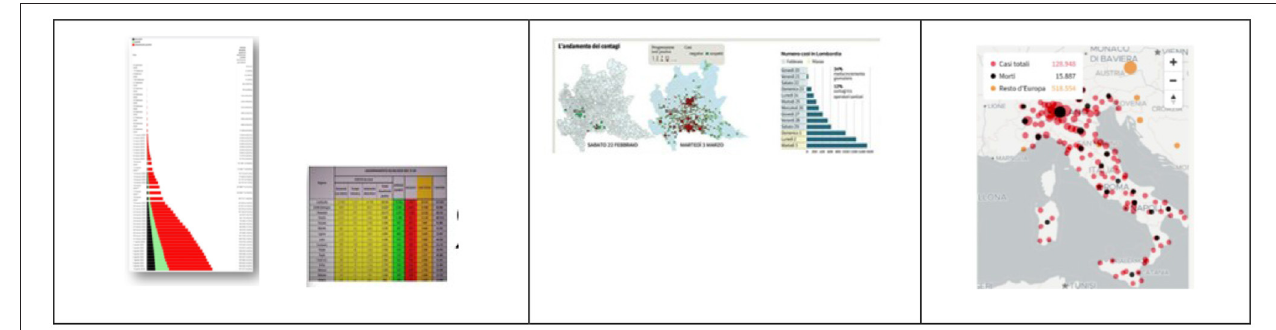
FIGURE 7 | Statistical analysis data organized by students’ workgroups on the daily problem.